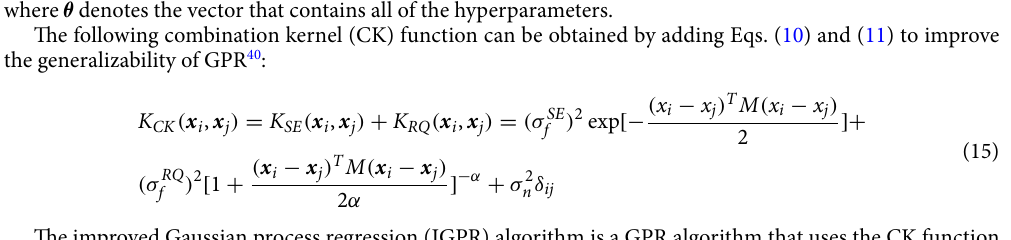
PSO-IGPR hybrid algorithm for geomechanical parameter